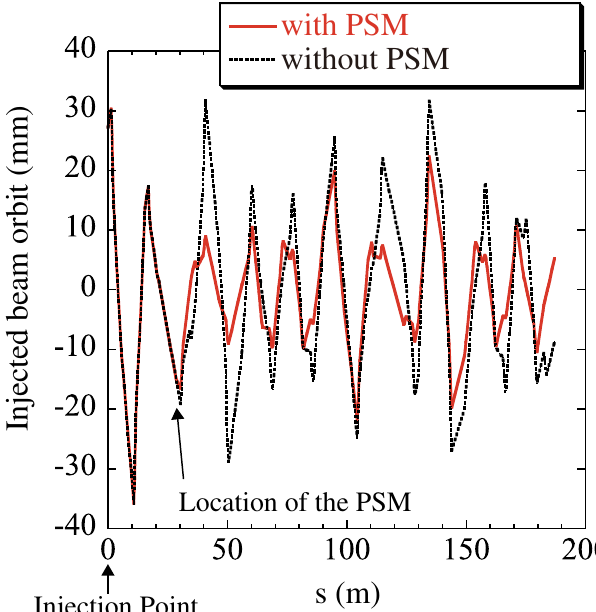
FIG. 8. (Color) Horizontal orbit of the injected beam at the PF ring with (red) and without (black) a PSM. The orbit displays the first circulation of the